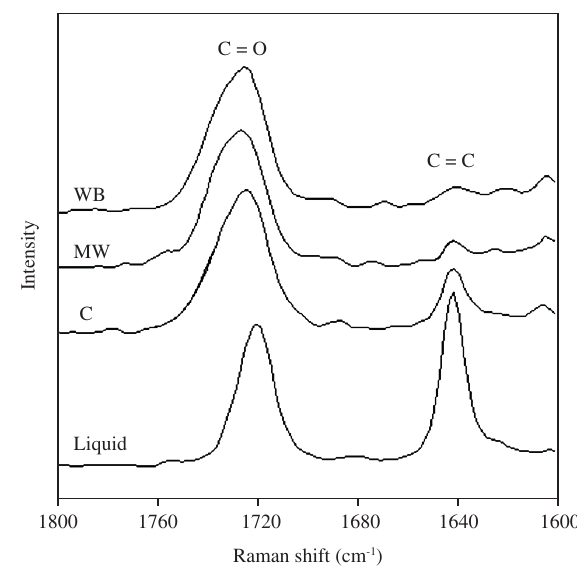
Figure 1. Raman spectra of material K: (liquid) monomer, (C) after polym- erization, (MW) after microwave irradiation with 550 W for 5 minutes, and (WB) after immersion in water at 55 °C for 10